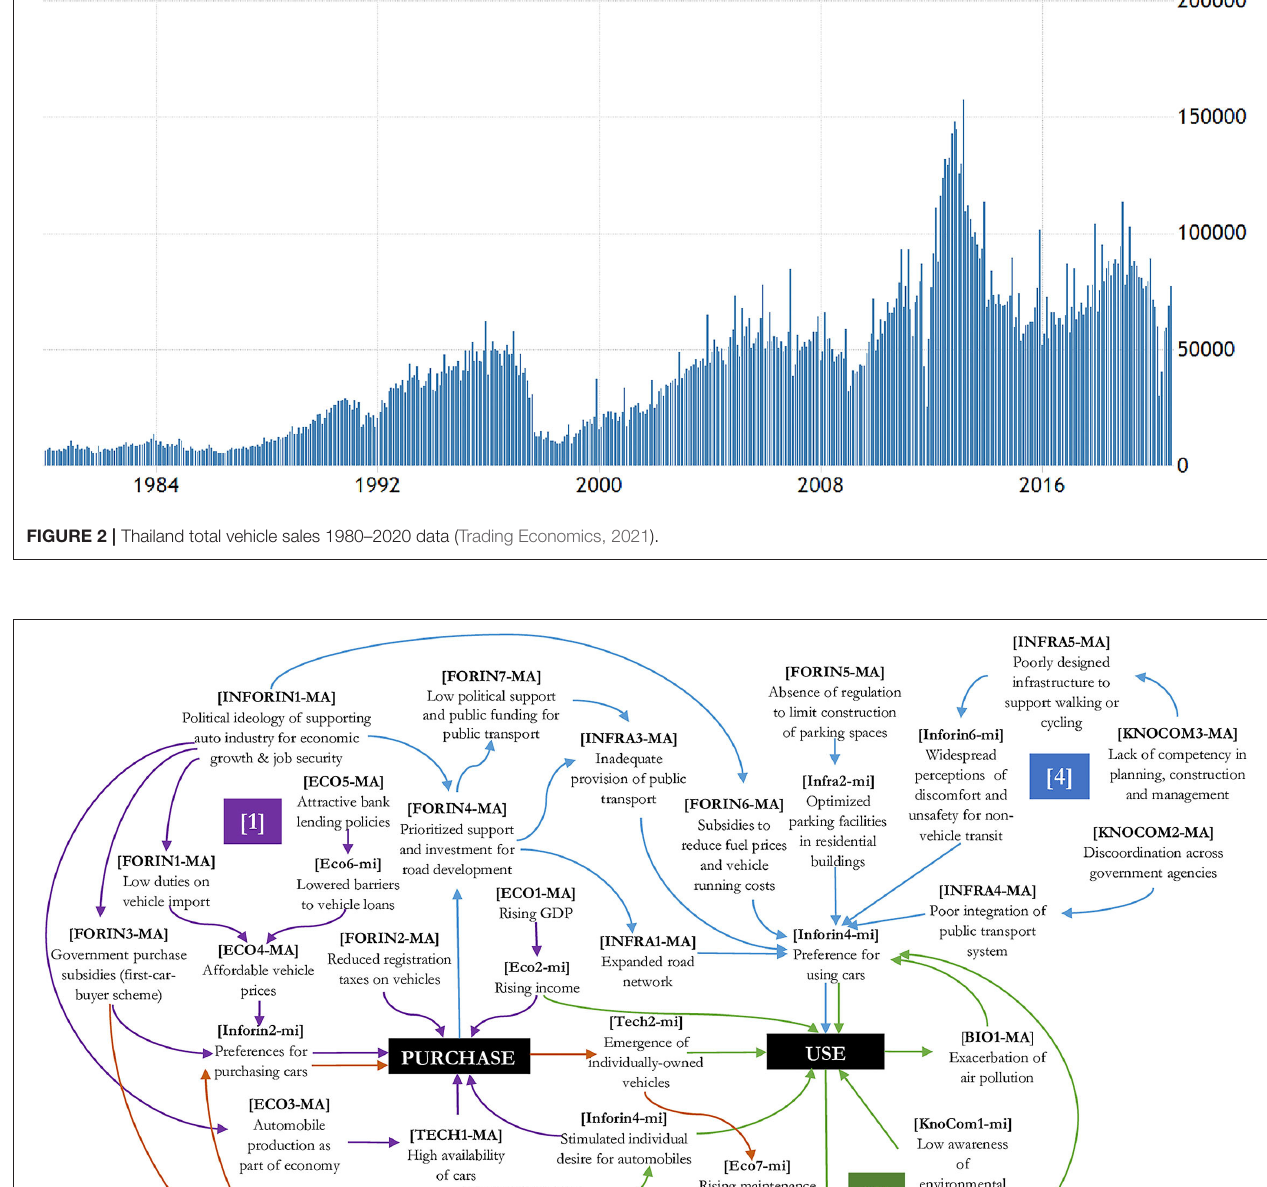
vehicles, since locally produced vehicles are exempted from import